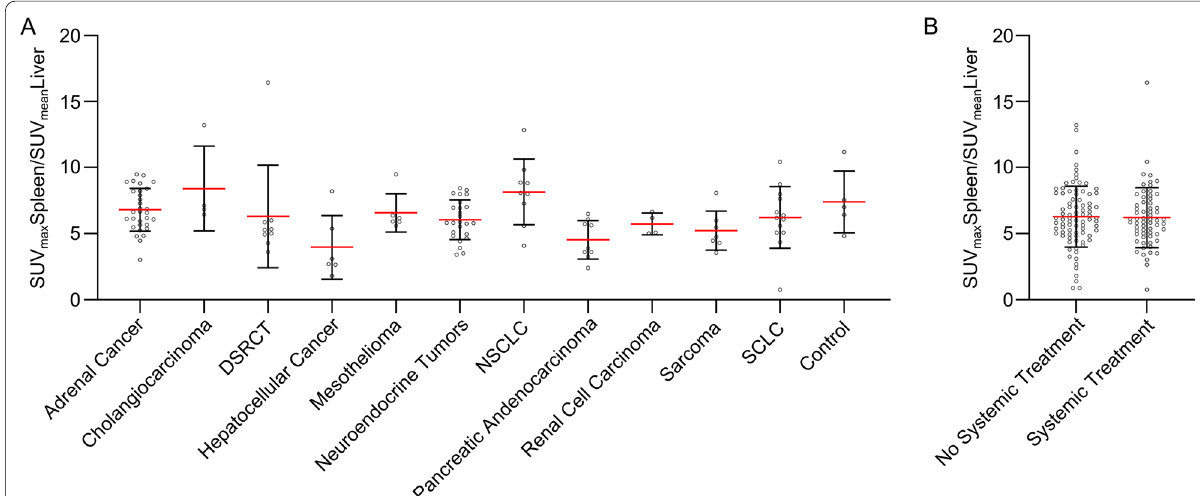
Fig. 2 Spleen [ 68 Ga]Pentixafor uptake levels show a wide variety within different entities, and are not affected by systemic treatment. A Comparison of spleen‑to‑liver ratios (SUV max Spleen/SUV mean Liver) of patients with adrenal cancer, n 31; cholangiocarcinoma, n 4; DSRCT, n 9; = = = hepatocellular carcinoma, n 6; mesothelioma, n 6; neuroendocrine Tumors, n 25; NSCLC, n 9; pancreatic adenocarcinoma, n 9; renal cell = = = = = carcinoma, n 4; sarcoma, n 7; SCLC, n 13 and control, n 5. B Comparison of spleen‑to‑liver ratios (SUV max Spleen/SUV mean Liver) of patients of = = = = all tumor entities included in the study, comparing patients without ongoing (no systemic treatment, n 85) to those with an ongoing systemic = therapy or systemic treatment within the last month prior to imaging (systemic treatment, n 63) =